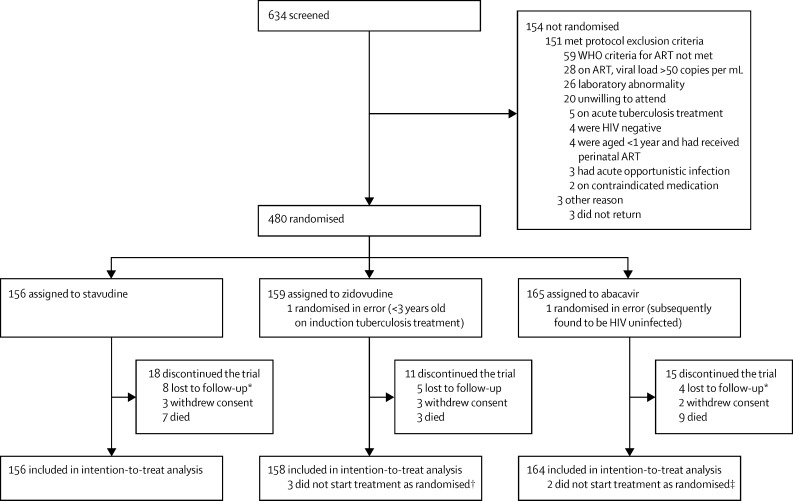
Trial profileART=antiretroviral treatment. *Includes one not seen after randomisation. †One participant started stavudine and substituted zidovudine at 12 weeks, two started abacavir and did not change (both prescribing errors). ‡Two started zidovudine and did not change (one prescribing error and one child changed regimen to match twin sibling).